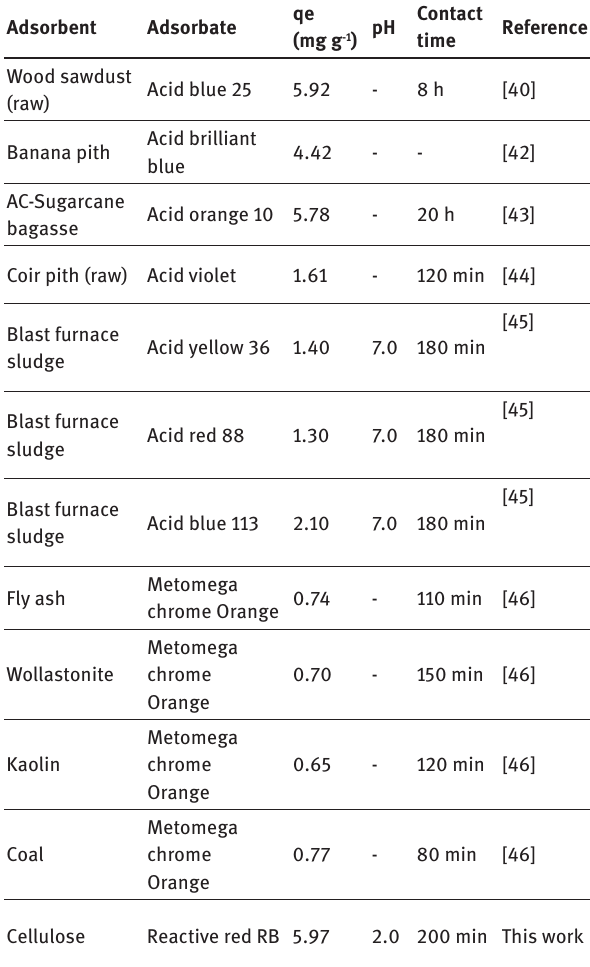
Table 2: Parameters obtained with different non-linear models of isotherms for adsorption of the reactive red RB dye in cellulose at different temperatures, pH 2.0.